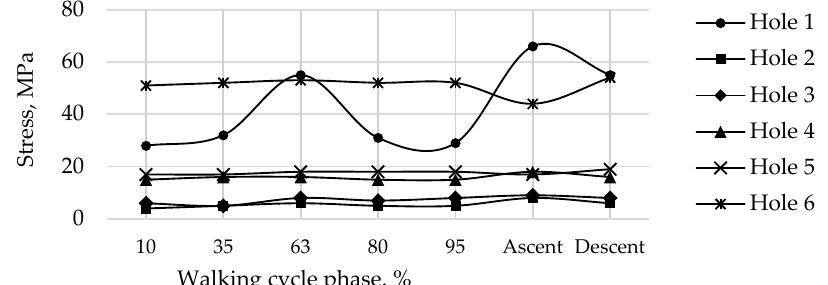
Figure 23. Maximum von Mises stress in the right pelvic bone at the edges of the holes for a pretension force of 500 N in different phases of the walking cycle. Table 3. Maximum von Mises stress in the system components with pretension force of 500 N.